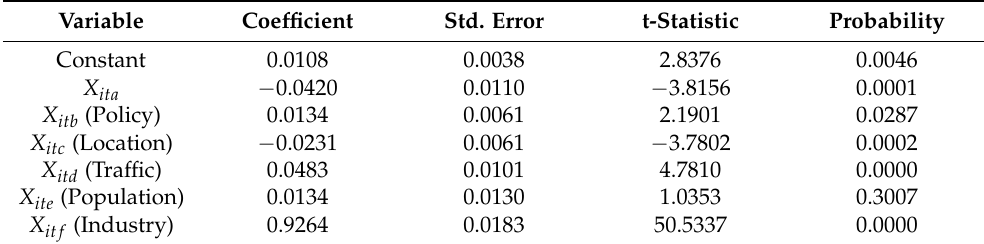
Table 2. OLS regression model validity